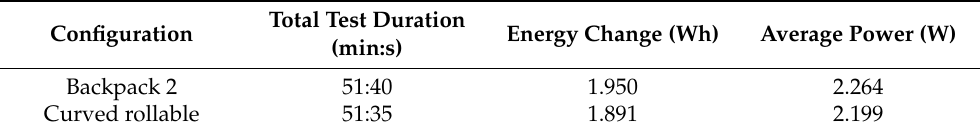
Figure 19. Electrical quantities at the terminals of the battery pack during PV generator tests in real use, full overcast conditions. Table 8. Results of PV generator tests in real use, small overcast conditions.